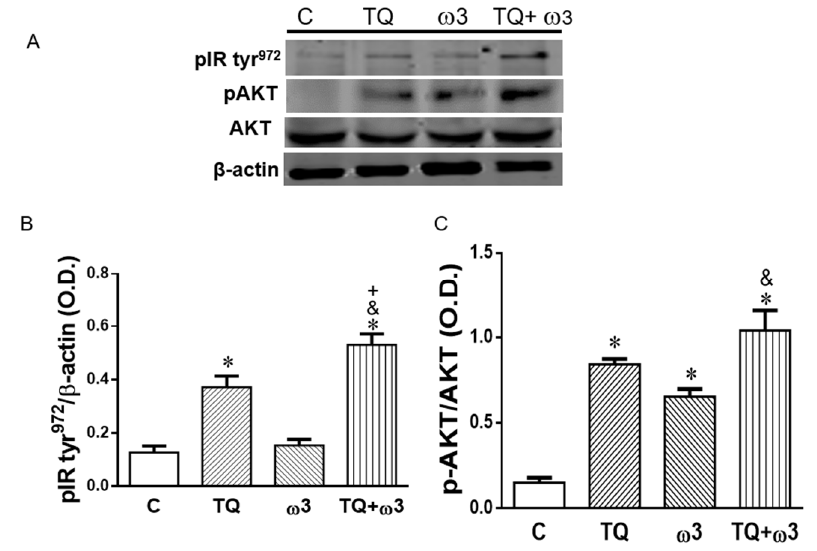
Figure 3. Effects of thymoquinone (TQ) and omega 3 ( ω 3) treatment on the protein expression of insulin signaling in 3T3-L1 adipocytes. Representative and graph of p-AKT and phosphorylated insulin receptor (pIR tyr 972 ), protein expression ( A – C ); 3T3-L1 adipocytes were treated with TQ 2 µ M, ω 3 20 µ M, and a combination of TQ and ω 3 for six days ( n = 4). * p < 0.05 vs Lean; + p < 0.05 vs TQ; & p < 0.05 vs ω 3.